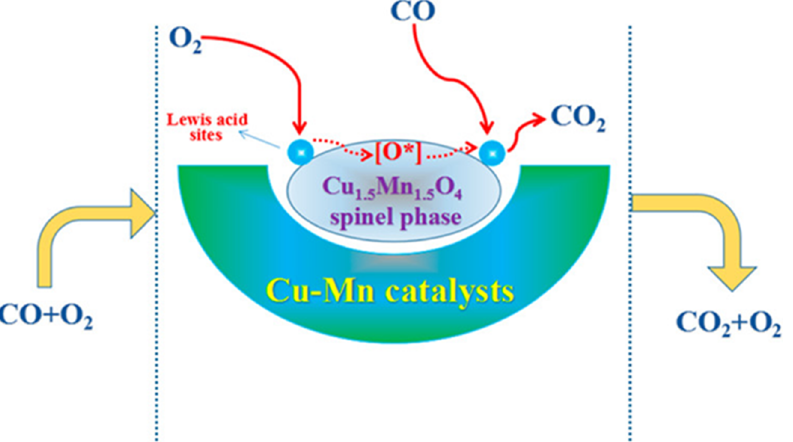
Figure 4. Mechanism of CO oxidation catalyzed by Cu 1.5 Mn 1.5 O 4 prepared with a hybrid (redox, complex forming, and hydrothermal) method (reproduced from ref.